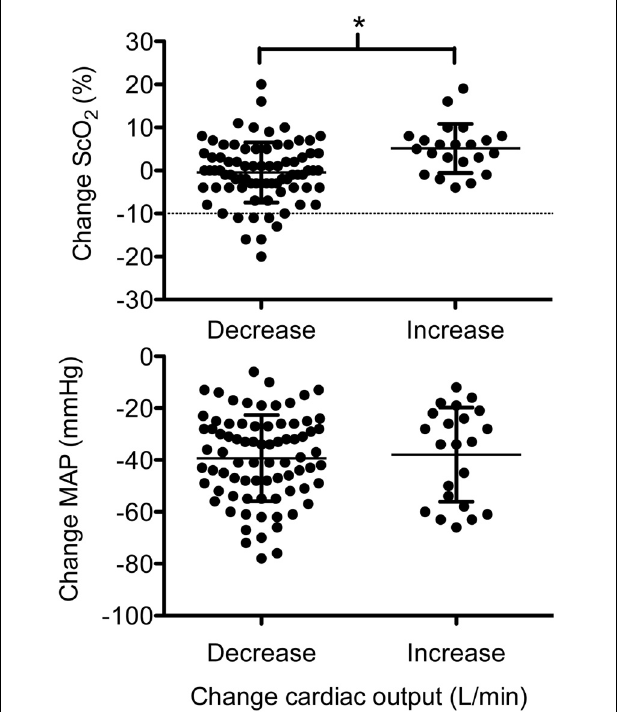
FIGURE 2 | The surgical changes in frontal lobe oxygenation (ScO 2 ) and mean arterial pressure (MAP) related to cardiac output (CO; decrease is CO below the preoperative level and increase is CO above the preoperative level). The dotted line straight line (upper panel) at − 10% represents the change in ScO 2 considered to be critical. ∗ Different value; P < 0 . 05.